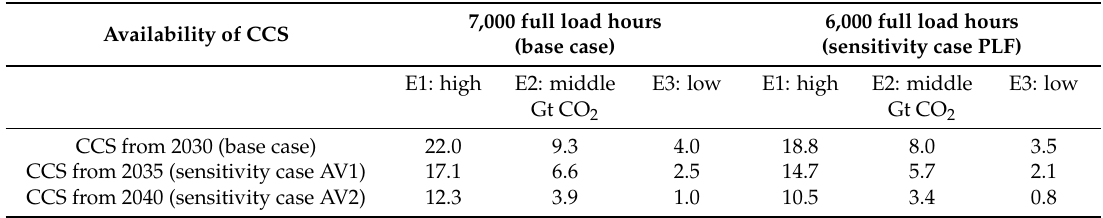
Table 4. Separated CO 2 emissions in South Africa according to coal development pathways E1–E3, cumulated over the lifetime of all power plants newly built until